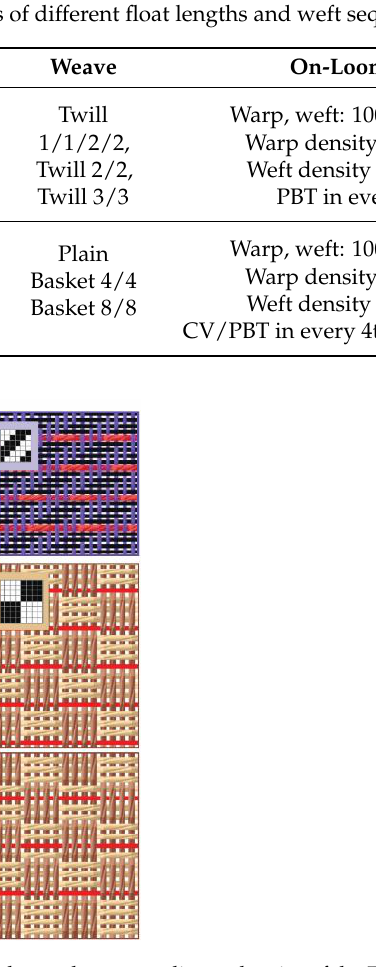
Figure 3. Simulations of woven fabrics shows the weave, linear density of the PBT yarns, and different weft sequence used.